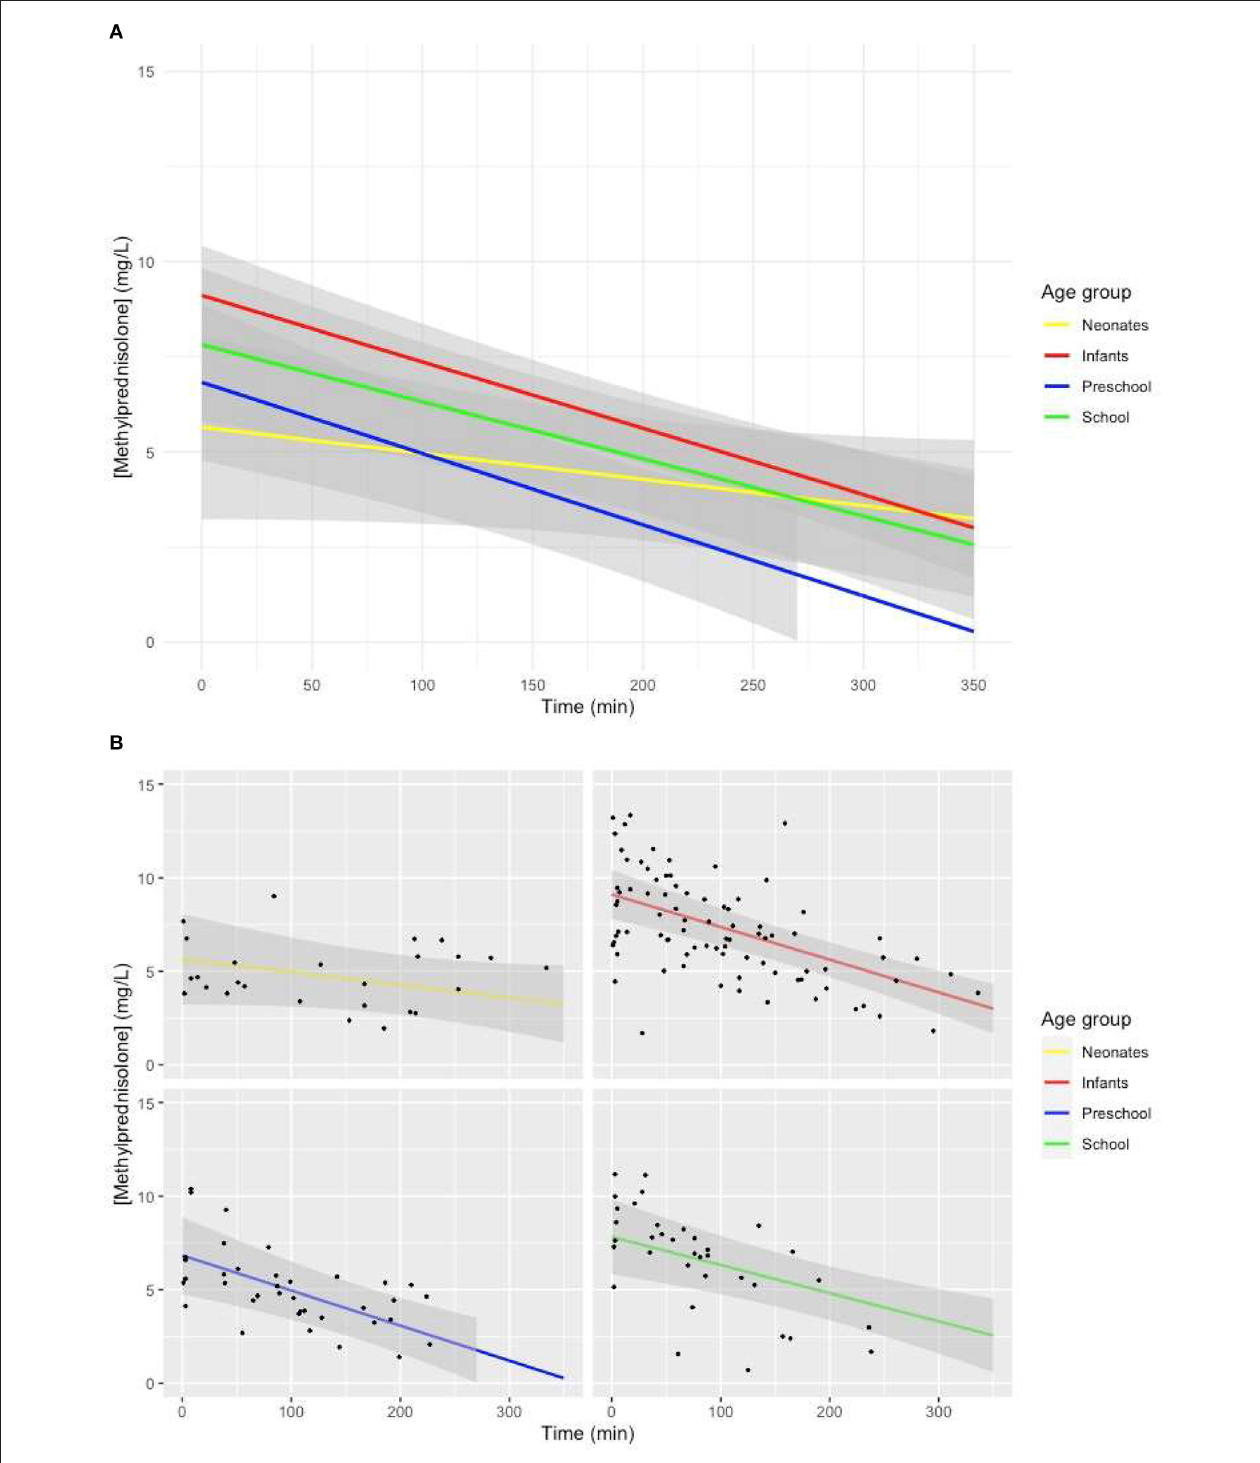
FIGURE 3 | (A) Predicted MP concentration (mg/L) vs. time (min) for all age groups after initiation of CPB based on the linear mixed-effects model. Gray ribbons: 95% confidence interval. T = 0: start of CPB. (B) Predicted MP concentration (mg/L) vs. time (min) for all age groups after initiation of CPB based on the linear mixed-effects model. Gray ribbon: 95% confidence intervals. T = 0: start of CPB.